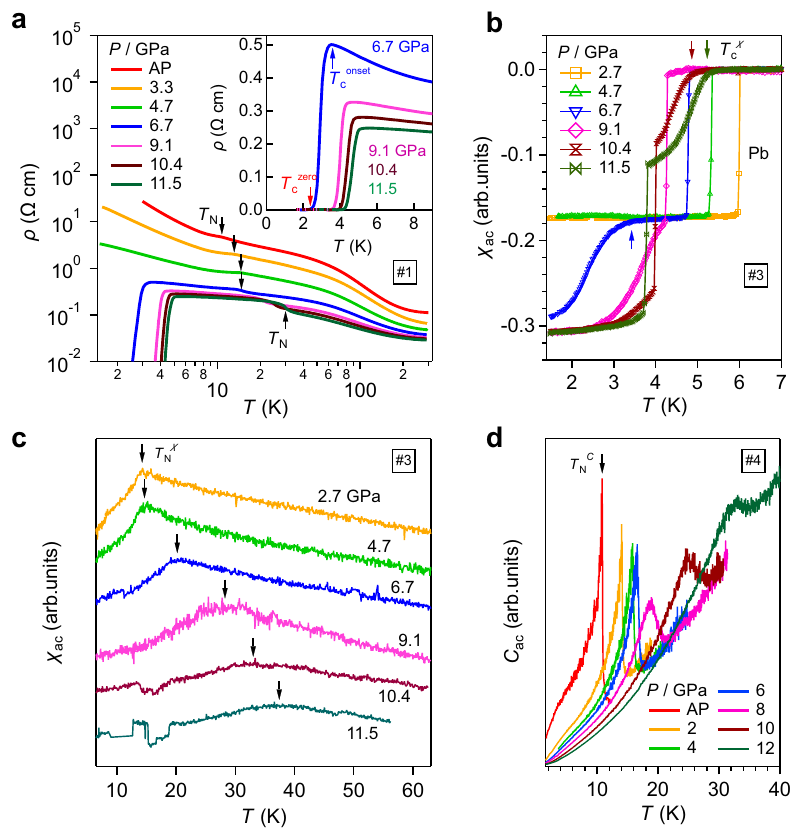
Fig. 2 Physical properties of EuTe 2 under high pressures. Temperature dependence of a resistivity ρ ( T ) for sample #1, b , c ac magnetic susceptibility χ T ) for sample #3, and d ac speci fi c heat C ac ( T ) for sample #4 under various pressures up to 12 GPa. Inset of a shows the enlarged view of low- T ρ ( T ) ac ( data. The antiferromagnetic transition temperatures T N and the superconducting transition temperatures T c zero and T c onset are marked by arrows in these